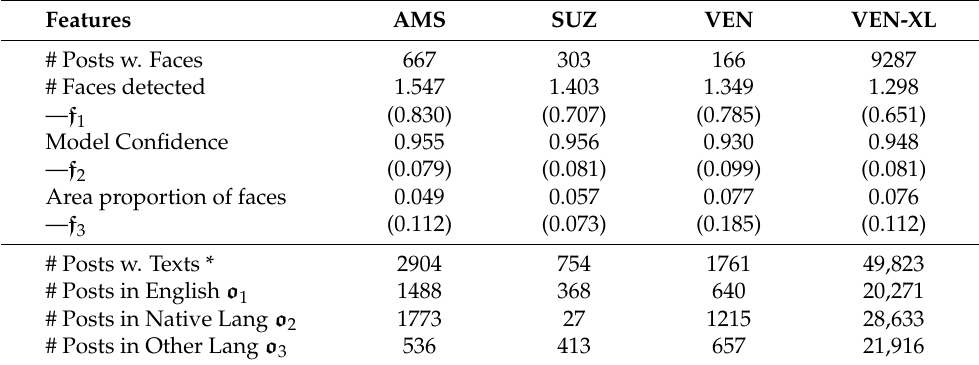
Table 4. Descriptive statistics (mean and standard deviation or counts, respectively) of the facial recognition results F as visual features and original language O as textual features. “#” means “the number of” in the table.